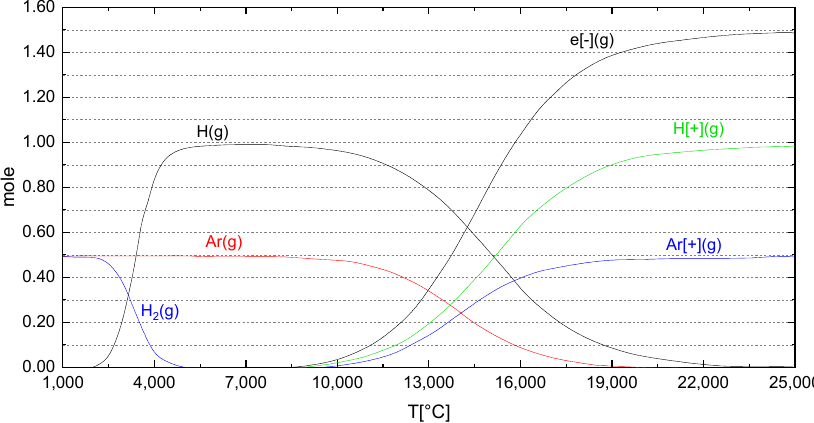
Figure 2. Gas composition of an H 2 –Ar mixture over the temperature at 100 kPa (FactSage ™ 7.1, Database; FactPS 2017) [14.]